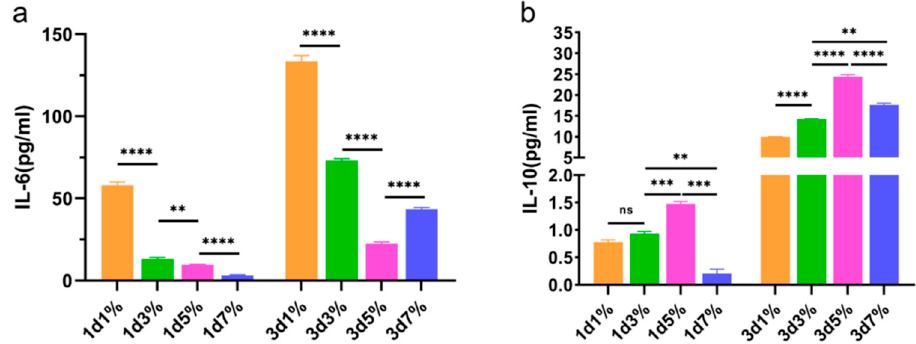
Figure 9. Concentrations of IL-6 ( a ) and IL-10 ( b ) in medium of RAW cells cultured on scaffolds at 1 and 3 days tested using ELISA, n = 3, ** p < 0.01, *** p < 0.001, **** p < 0.0001.